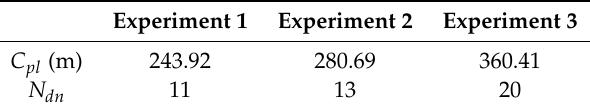
Table 2. Experimental statistical